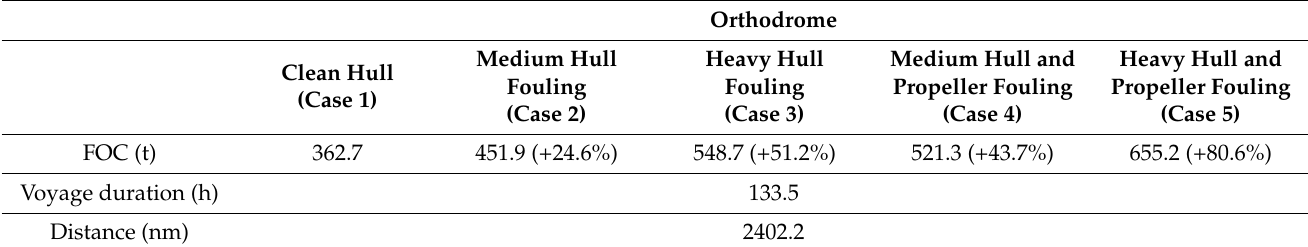
Table 3. Comparison of orthodromic paths.